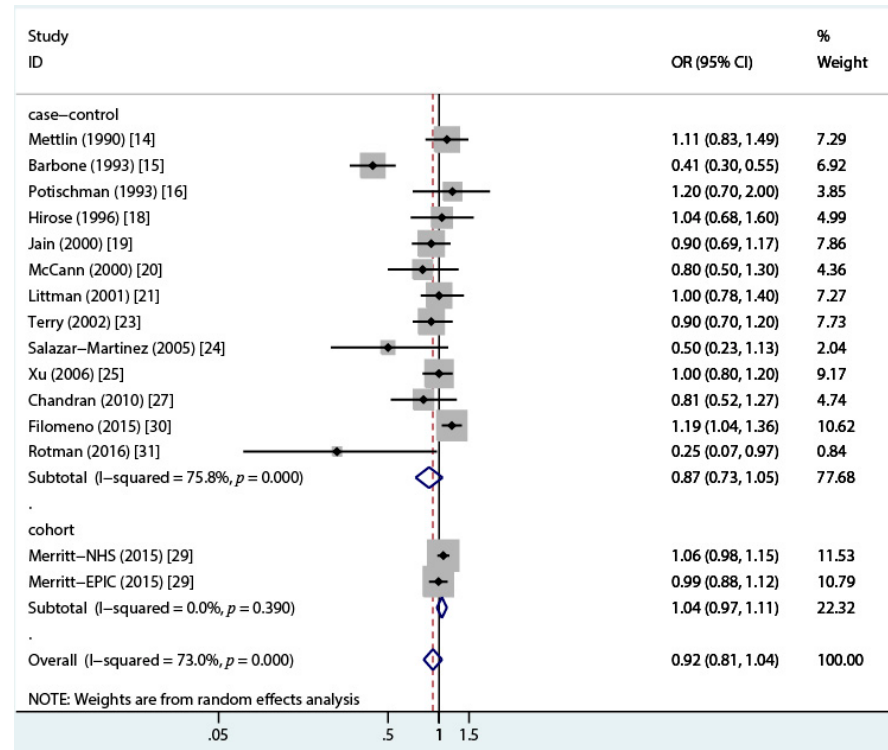
Figure 2. Forest plot of the summary risk estimate of endometrial cancer in the highest category of dairy intake compared with that in the lowest category by the random effects model. OR, odds ratio; CI, confidence interval.